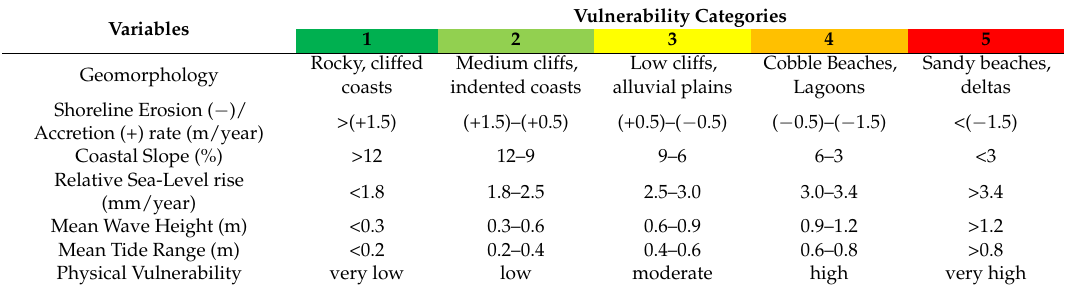
Table 1. Ranges for vulnerability ranking of the six CVI variables. The ranges of vulnerability ranking, used in this study, are those proposed for the coastal environment of Greece